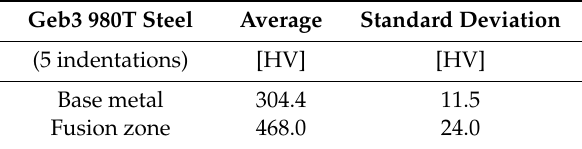
Table 6. Vickers micro-hardness test of Gen3 980T